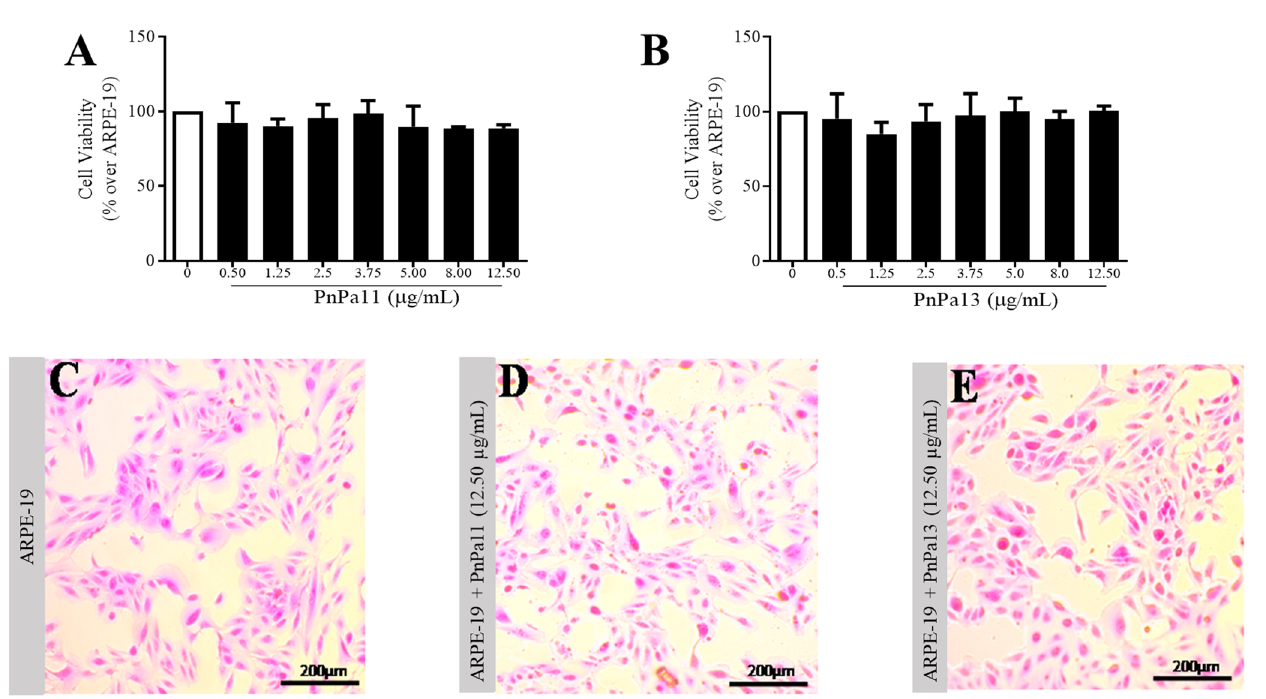
Figure 1. Cytotoxicity of PnPa11 and PnPa13 over ARPE-19 cells. (A) Visualization by optic microscopy of ARPE-19 cells after the treatment with PnPa11. (B) Visualization by optic microscopy of ARPE-19 cells after the treatment with PnPa13. (C) Visualization by optic microscopy of ARPE-19 cells. (D) Cell viability in the presence of increasing concentrations of PnPa11. (E) Cell viability in the presence of increasing concentrations of PnPa13. Comparison among groups was performed using one-way ANOVA with Tukey’s post-test (n = 3 well per dose in three independent experiments). The control group was set as 100%. The data are represented by mean ± SD. *Significant difference as compared to control (*p <